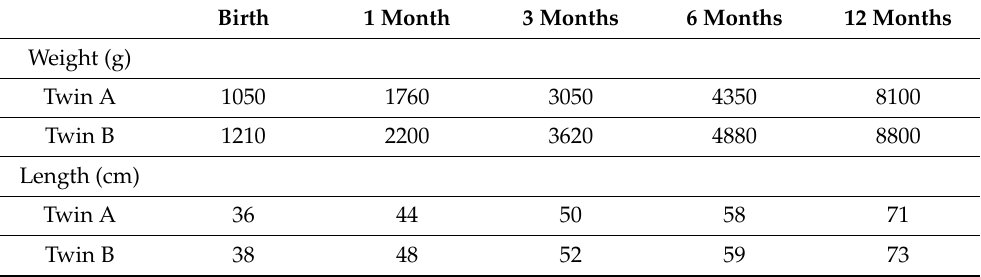
Table 1. Main auxological parameters assessed in a pair of preterm twin girls (twin A and B) from birth to 12 months of life.